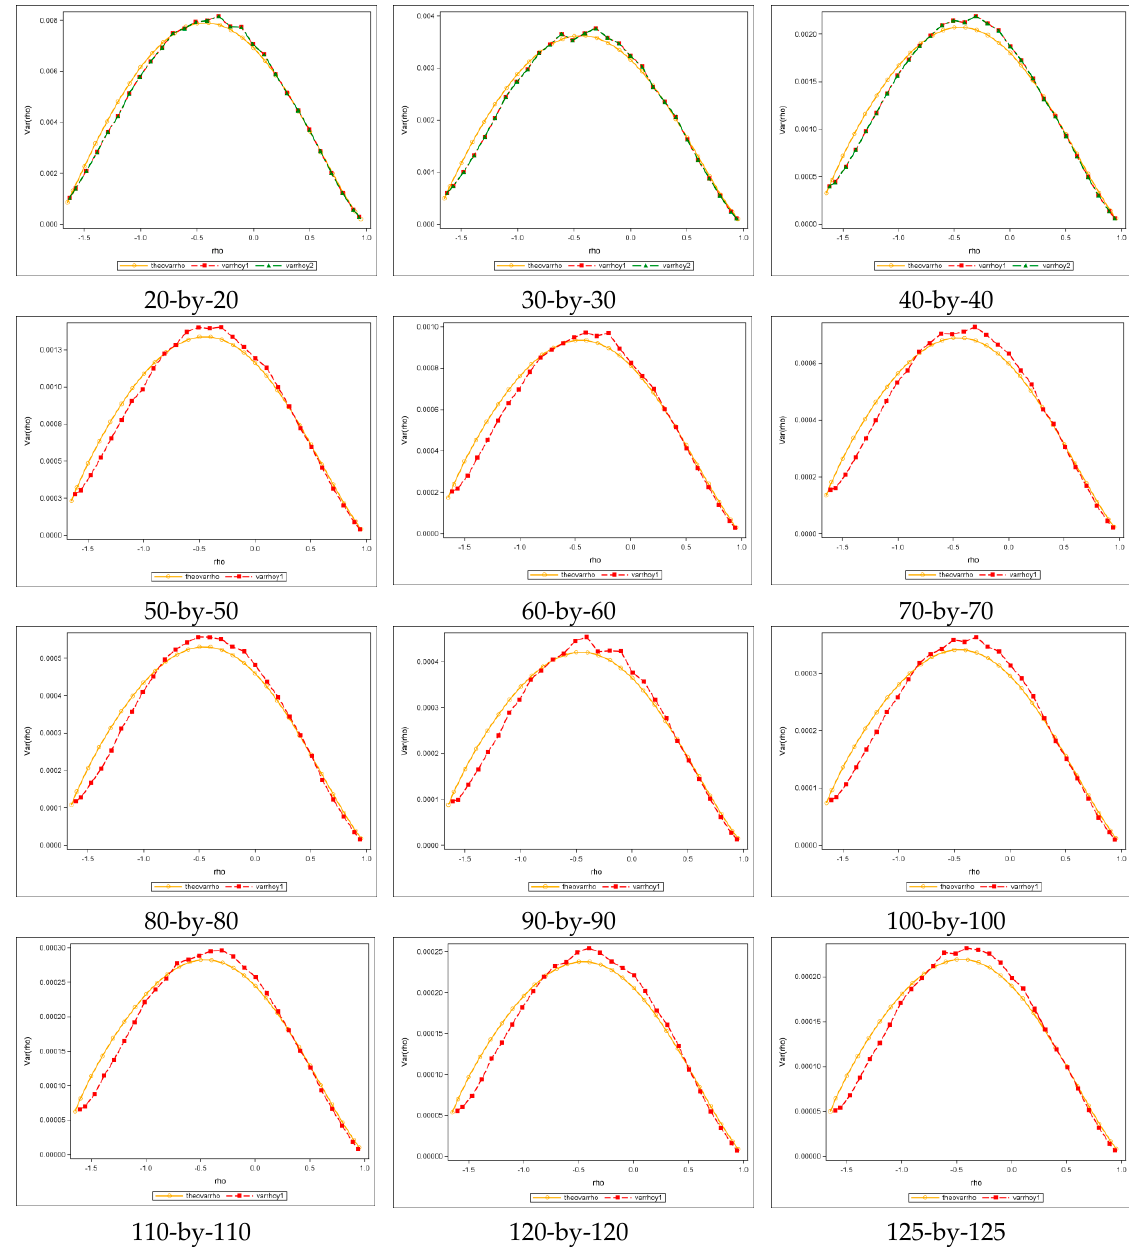
Figure A6. Theoretical variances (orange) versus exact variances (red and green) obtained by approximating the Jacobian term and employing new MLEs with different sample sizes for the square tessellation with hexagonal adjacency.